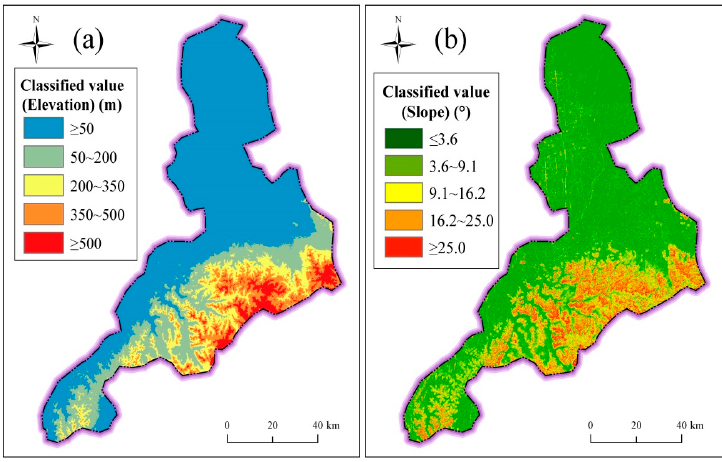
Figure 10. Classification of topography: ( a ) elevation; and ( b ) slope.